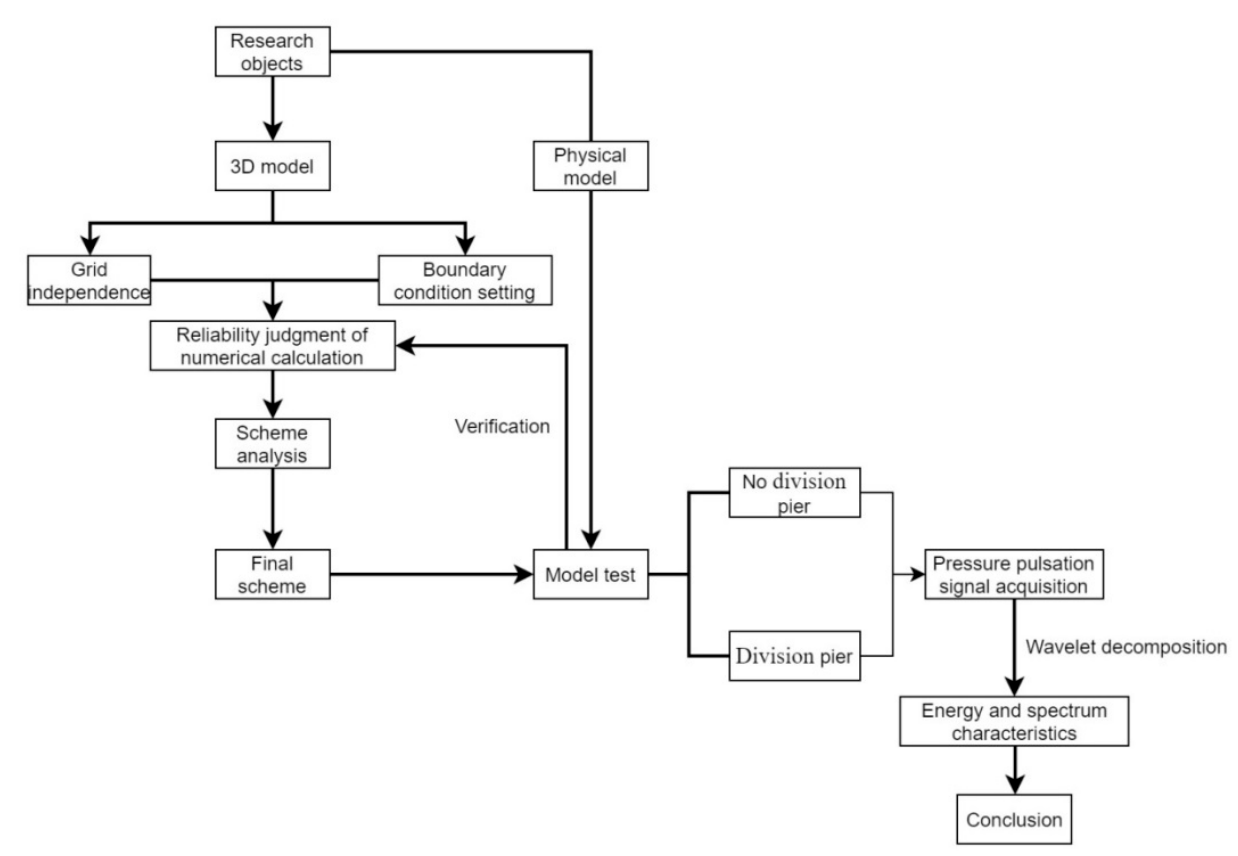
Figure 1. Analysis flow chart.